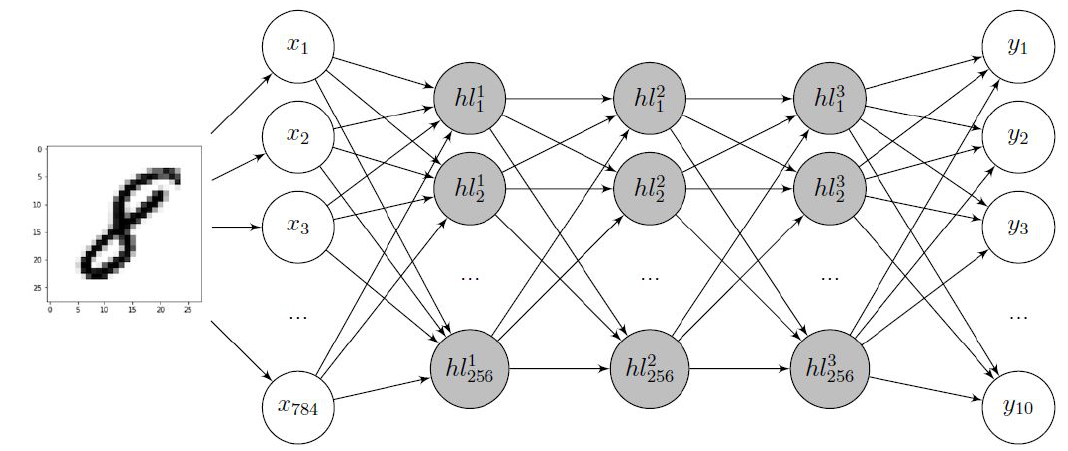
Figure 9. Schematic of the fully connected DNN architecture with 784 nodes in the input layer ( x i ), 10 nodes in the output layer ( y j ), and three hidden layers (in gray) with 256 perceptron units ( hl i